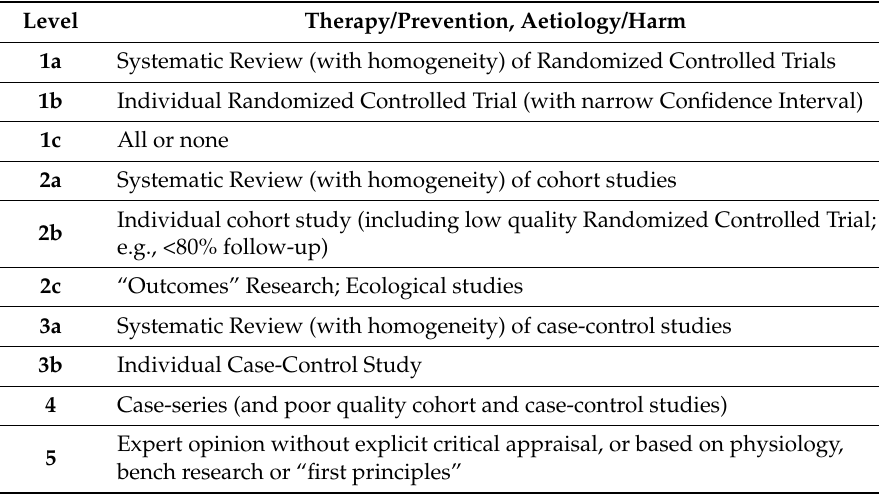
Table 2. Levels of Evidence (Oxford Centre for Evidence-based Medicine—March 2009) [107].